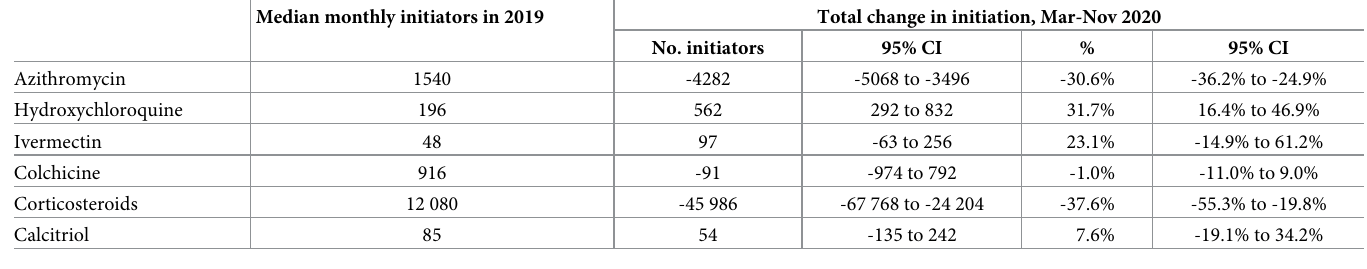
Table 2. Change in number of initiators from March to November 2020 estimated using autoregressive integrated moving average models (ARIMA). Estimates are based on a 10% sample of PBS-eligible people.